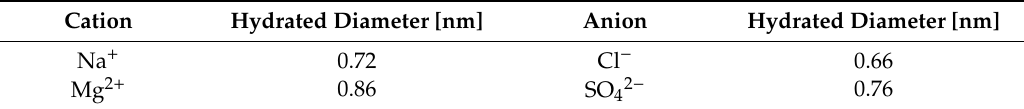
Table 2. The hydrated ion diameters of Na + , Mg 2+ , Cl - and SO 42- [24].